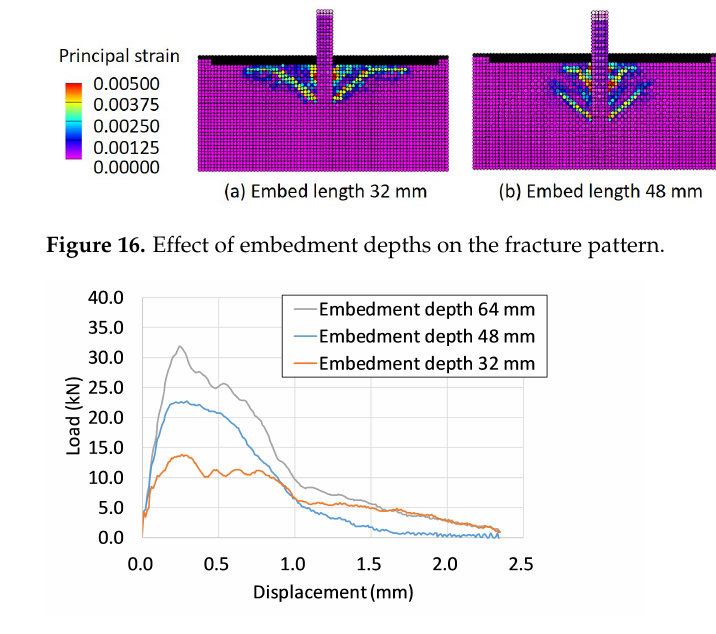
Figure 17. Load-displacement relationships with different embed